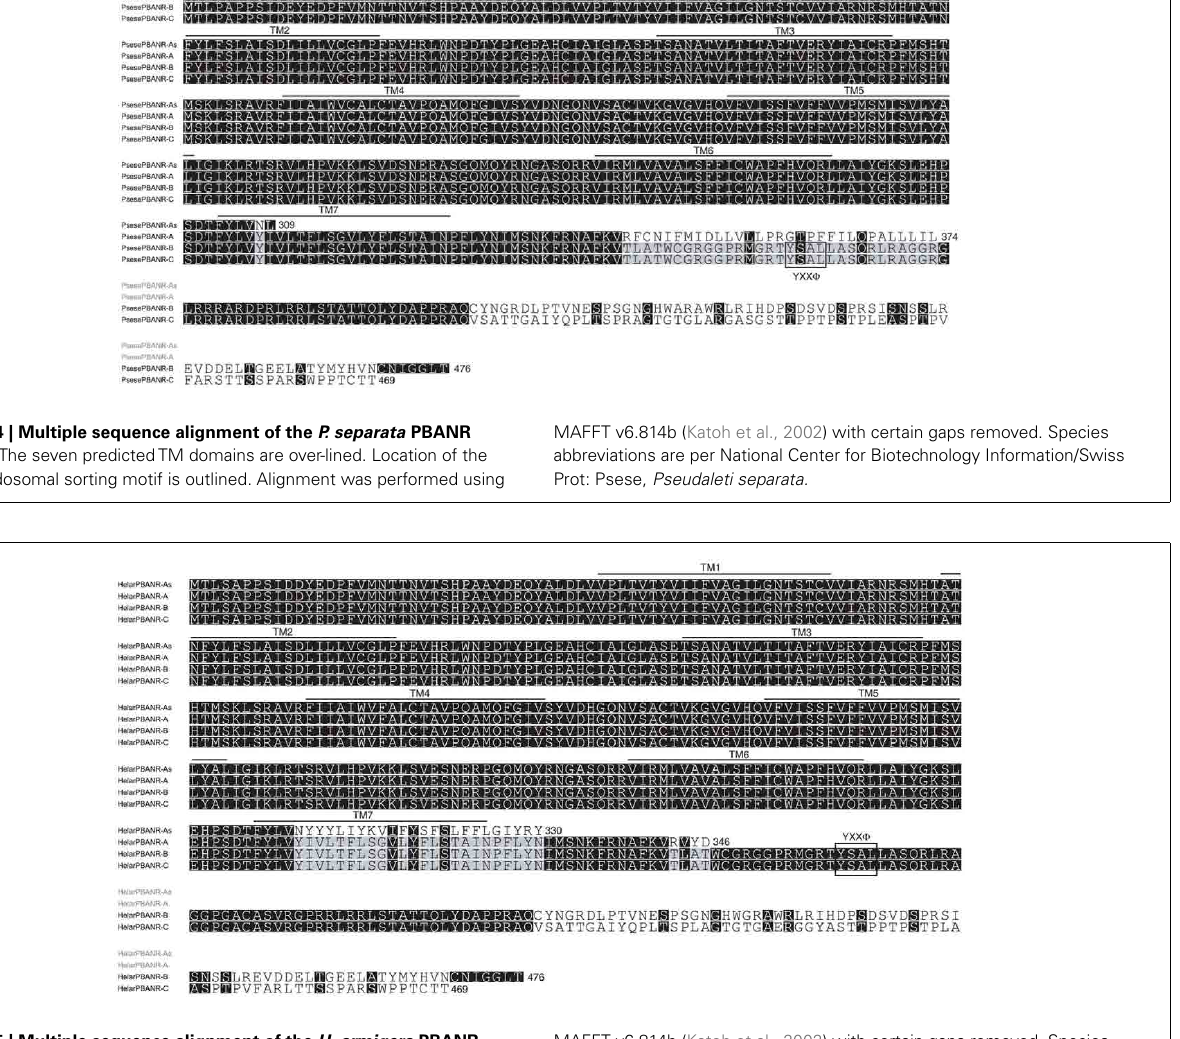
FIGURE 5 | Multiple sequence alignment of the H. armigera PBANR variants. The seven predictedTM domains are over-lined. Location of the YXX Φ endosomal sorting motif is outlined. Alignment was performed using